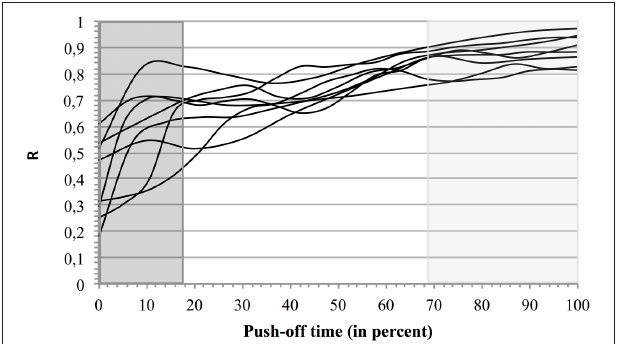
FIGURE 6 | Energetic efficiency R in 3 types of coordination. For each jumper the curves of R as function of time are presented on a background indicating the mean identified segmental coordination types (percent of the push-off time). The first type (Ty i ) is indicated by a dark gray background, the second (Ty inter ), by a white background, and the third one (Ty fin ), by a light gray background.